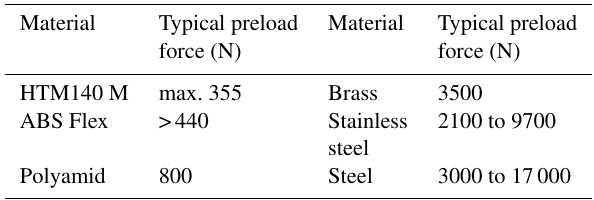
Figure 10. Relative change in resistance over 16h after fastening of an ABS Flex screw. Table 2. Typical preload forces for ISO M6 screws made from dif- ferent materials (Reyher,